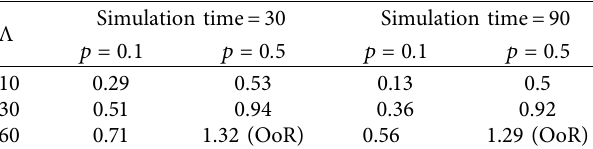
Table 9: Results for scenario 5 aimed to get minimum μ and ϕ required to I ( t ) ⟶ 0, assuming μ � ϕ .